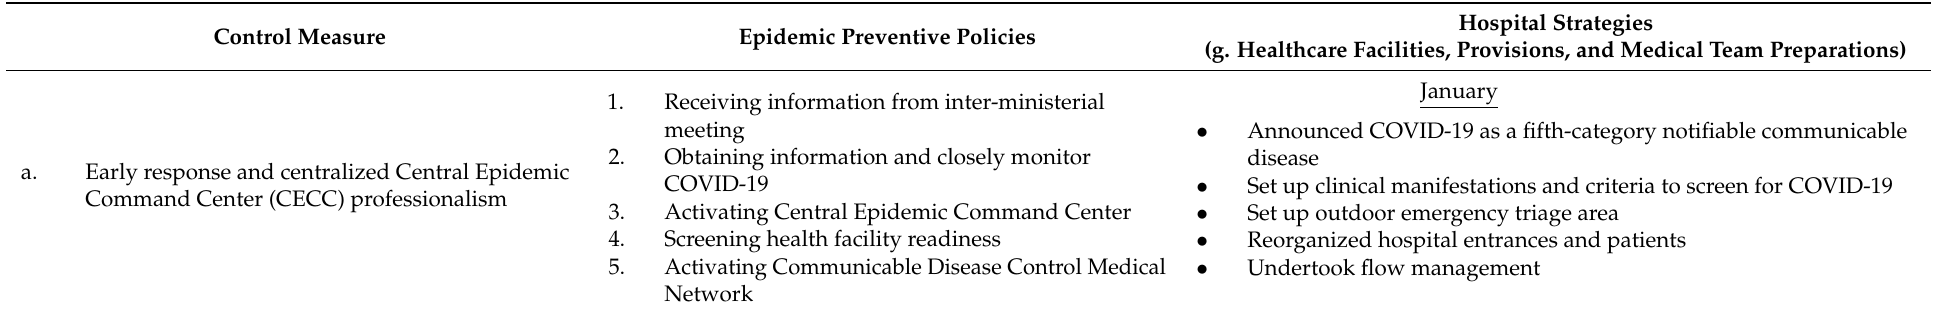
Table 3. Epidemic preventive policies and hospital strategies implemented in